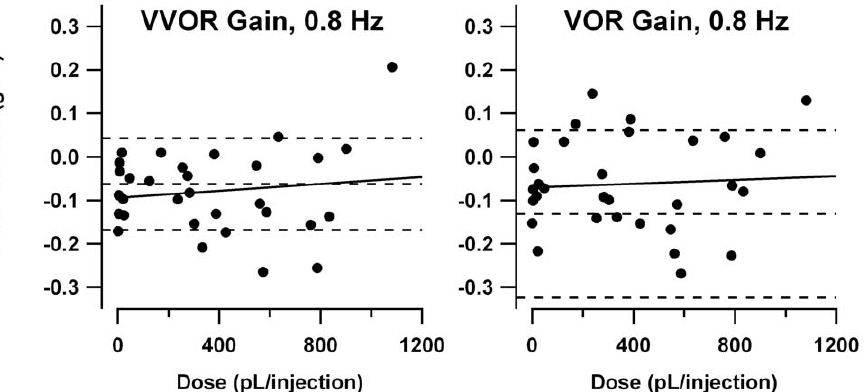
Figure 10. Change in VVOR gain (left panel) and VOR gain (right panel) following intrafloccular 4-AP injections in tottering , plotted as a function of volume of each injection. Horizontal dashed lines indicate the mean and 6 2SD confidence interval for gain change in the systemic saline sessions of young tottering . 4-AP did not engender any changes in gain proportional to drug dosage.